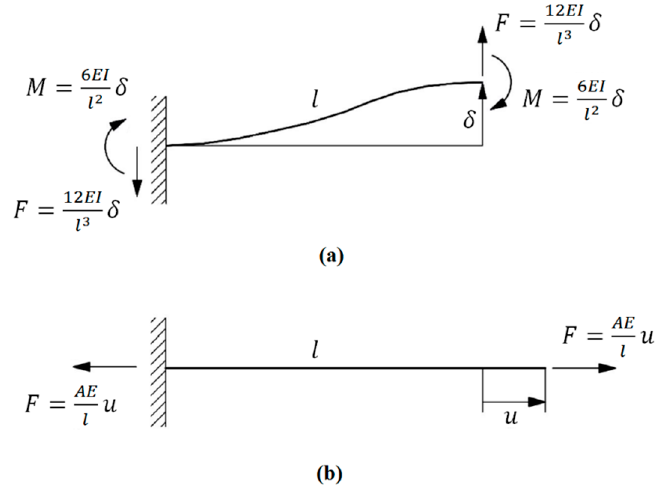
Figure 5. Forces and moments required to cause ( a ) lateral displacement δ with no rotation at the free end of a beam; and ( b ) simple axial expansion u